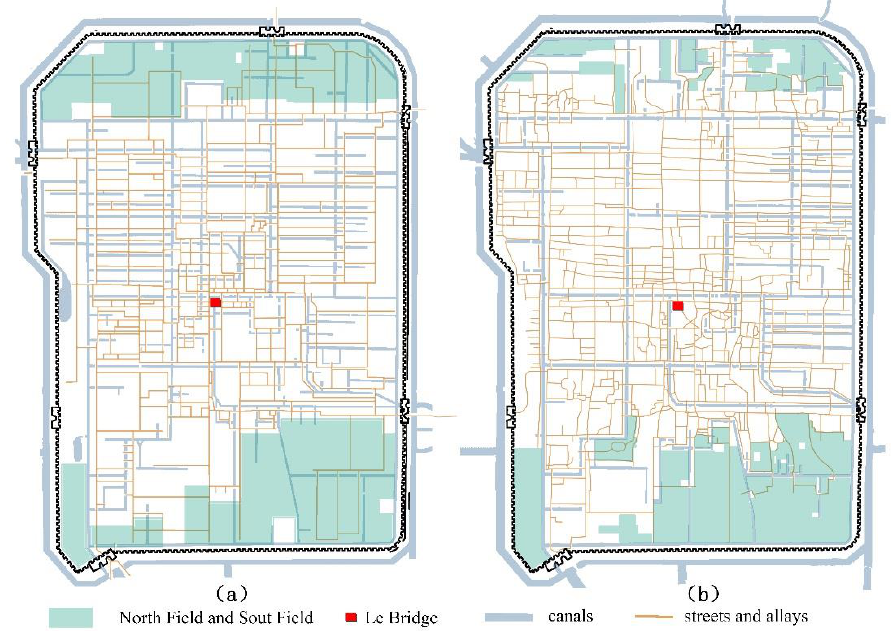
Figure 8. Comparation between Map of Pingjiang and Map of Gusu city. ( a ) the Song Dynasty (1239). ( b ) the Qing Dynasty (1745).